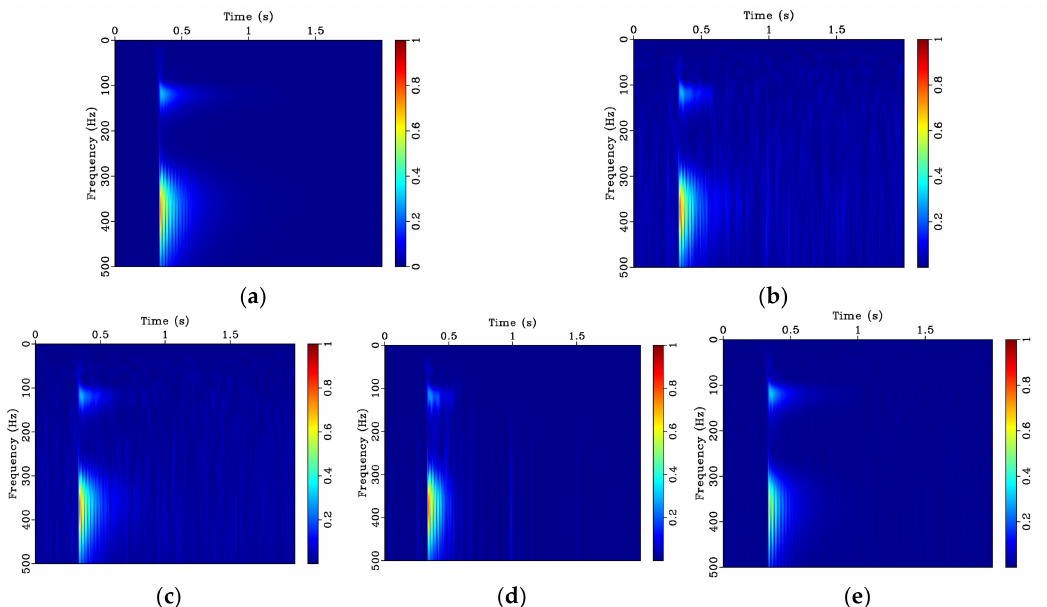
Figure 6. Time-frequency spectrum for simulated damped vibration signal with random noise and denoising results: ( a ) spectrum for original signal; ( b ) spectrum for original noisy signal; ( c ) median filtering result; ( d ) wavelet denoising result and ( e ) bilateral filtering